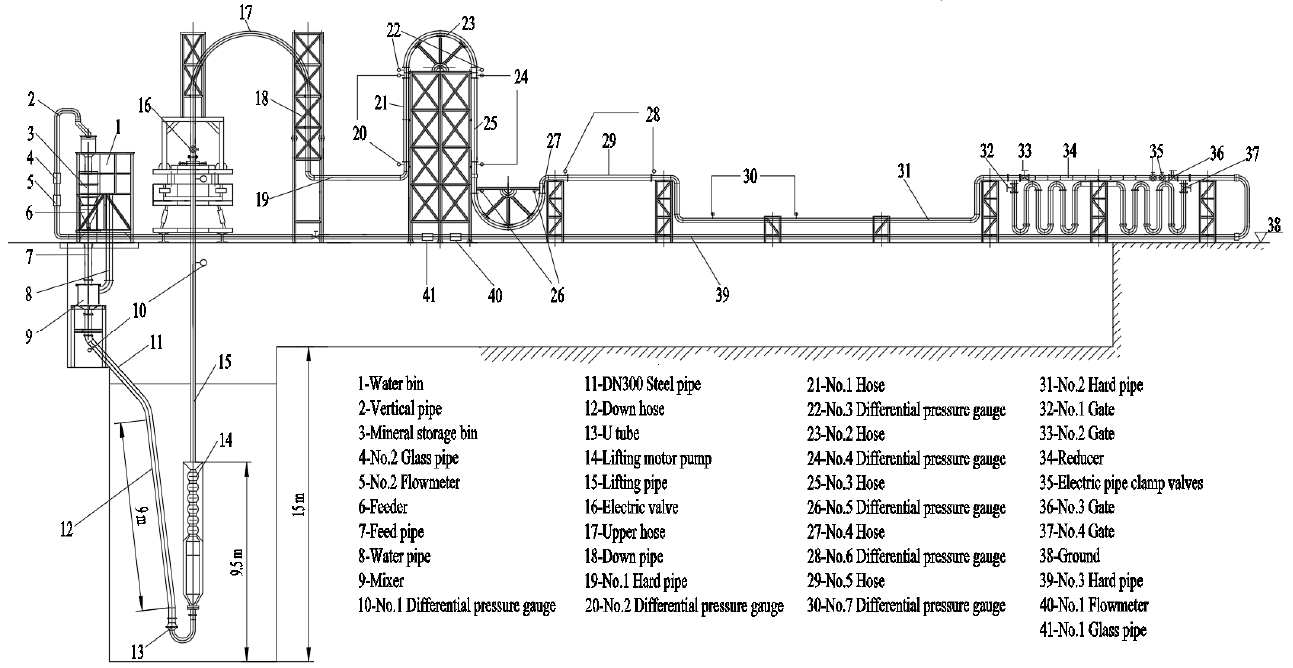
Figure 3. Nodule degradation experimental system.